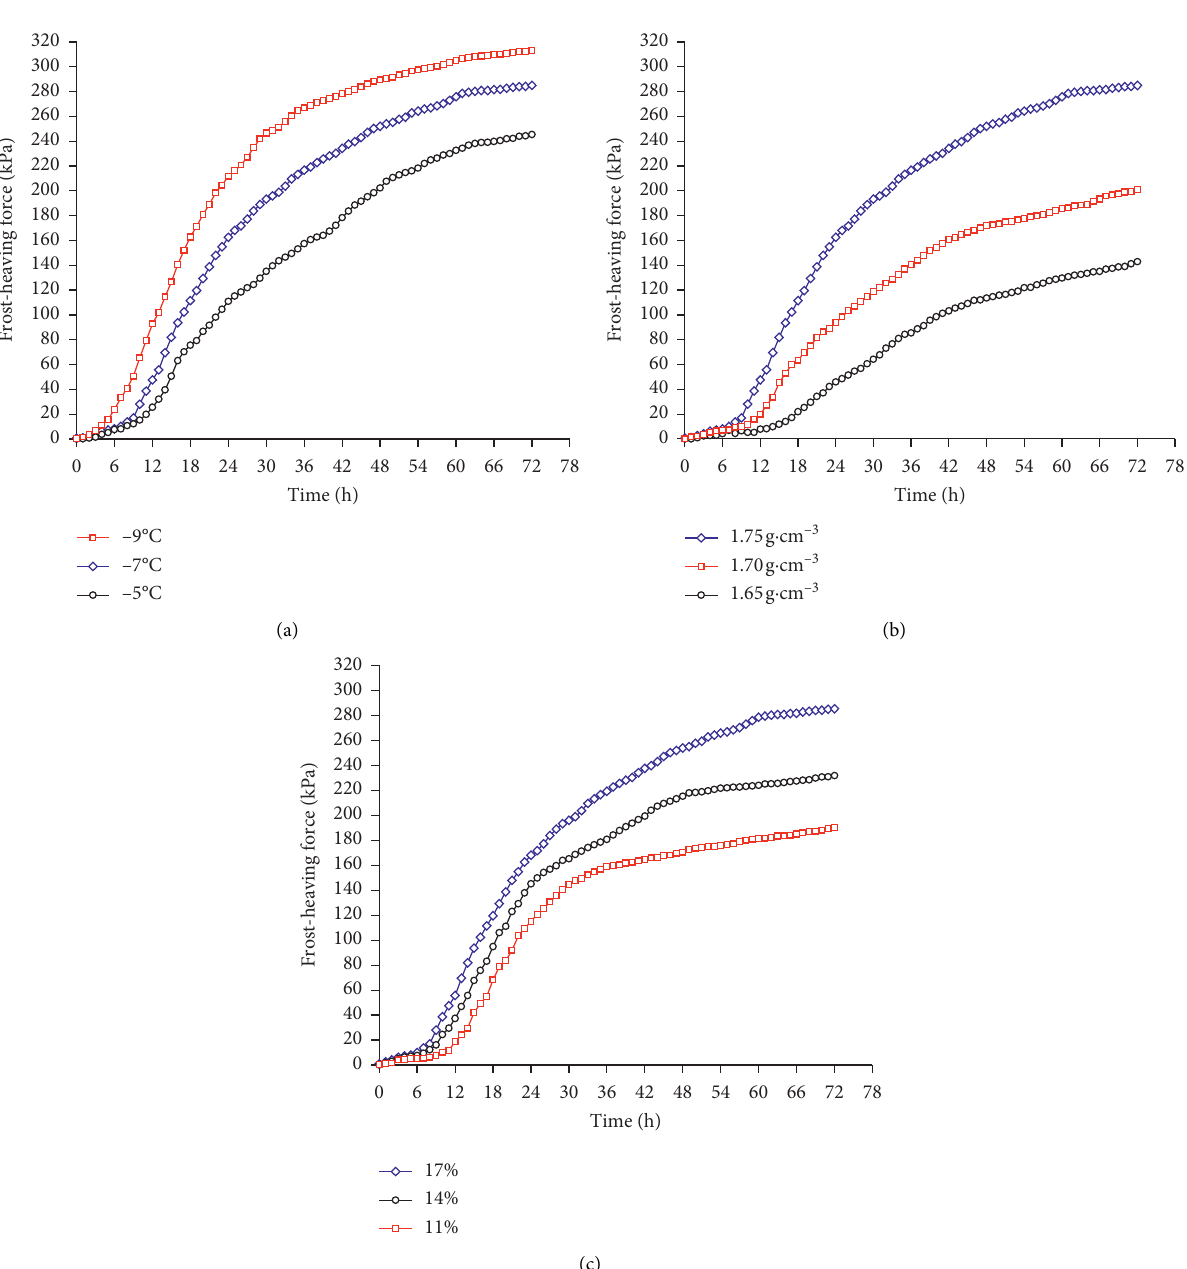
Figure 7: Frost heave forces under (a) different top-plate temperatures, (b) dry densities, and (c) initial moisture